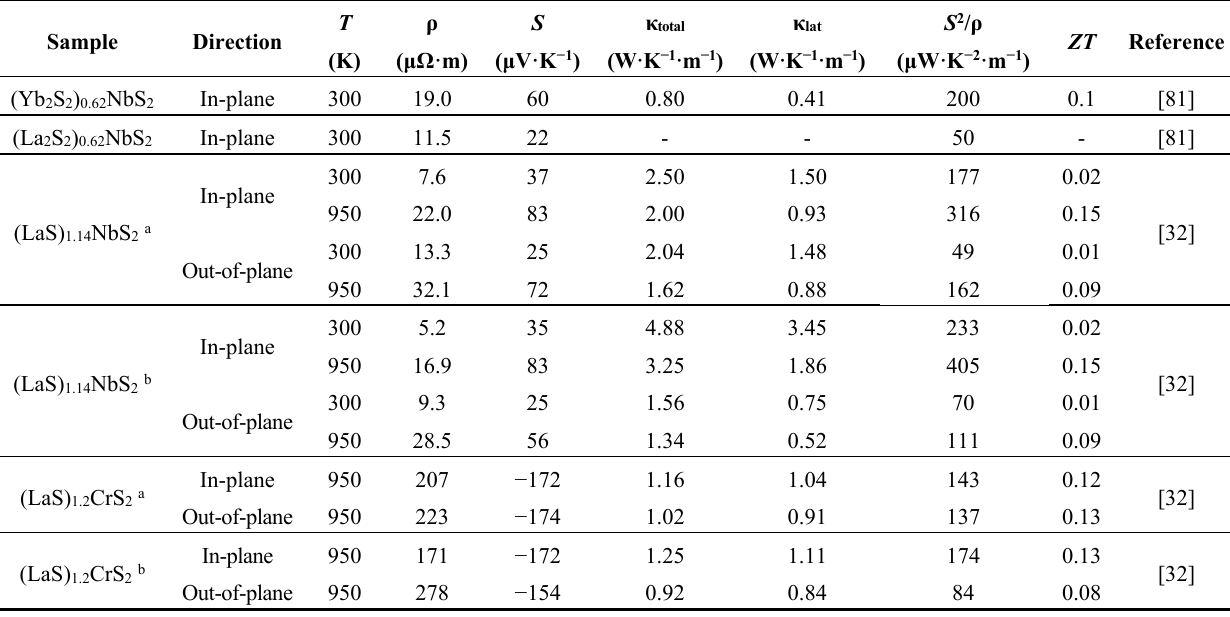
Table 2. Seebeck coefficient ( S ); electrical resistivity ( ρ ); total thermal conductivity ( κ total ); lattice thermal conductivity ( κ lat ); power factor ( S 2 / ρ ); and thermoelectric figure of merit ( ZT ) in the in-plane ( ab -plane) and out-of-plane ( c -axis) directions of state-of-the-art misfit layered sulfides: [MS] 1+ m TS 2 (M = La, Yb; T = Cr, Nb)